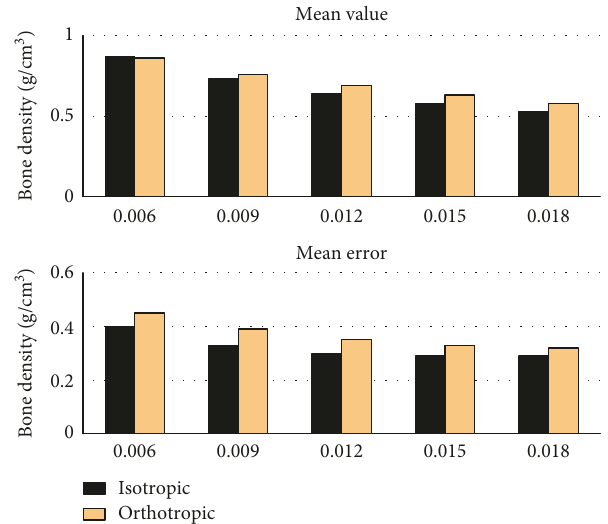
Figure 3: The mean value and mean error of the bone densities simulated by the isotropic and orthotropic algorithms. Five values of reference stimulus Ψ (0.006 ~ 0.018) are used for simulation, 0